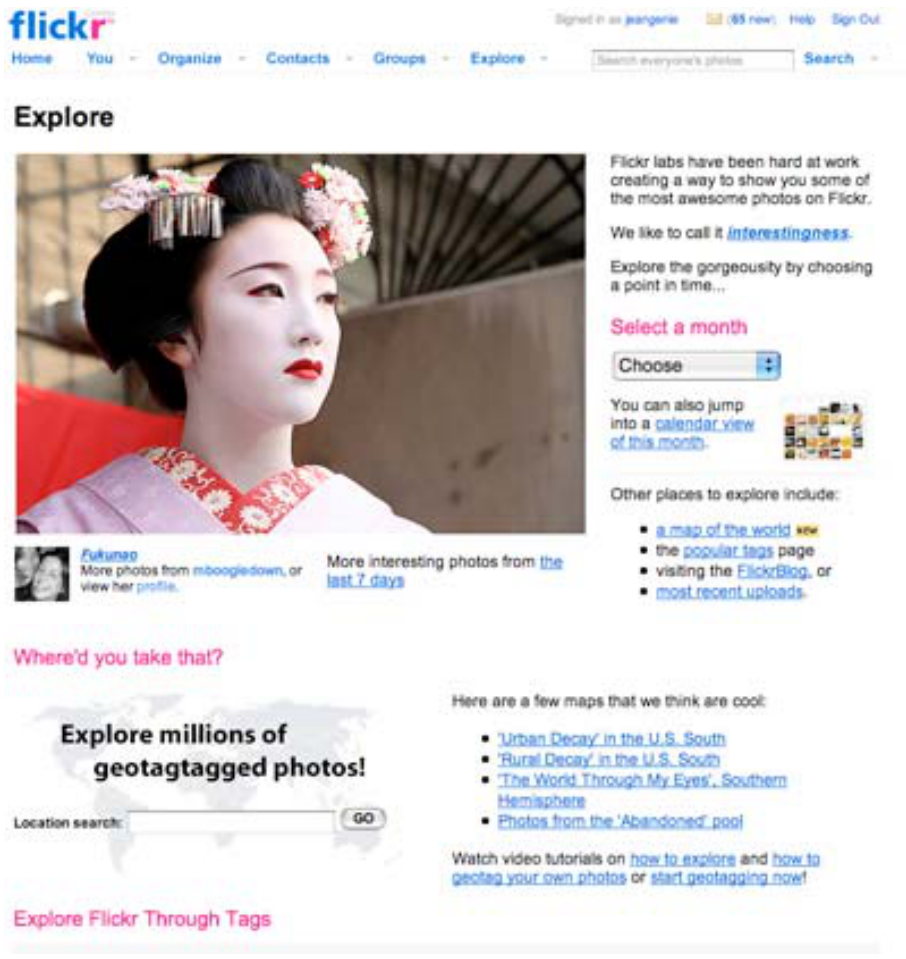
Figure 4: Flickr—Explore